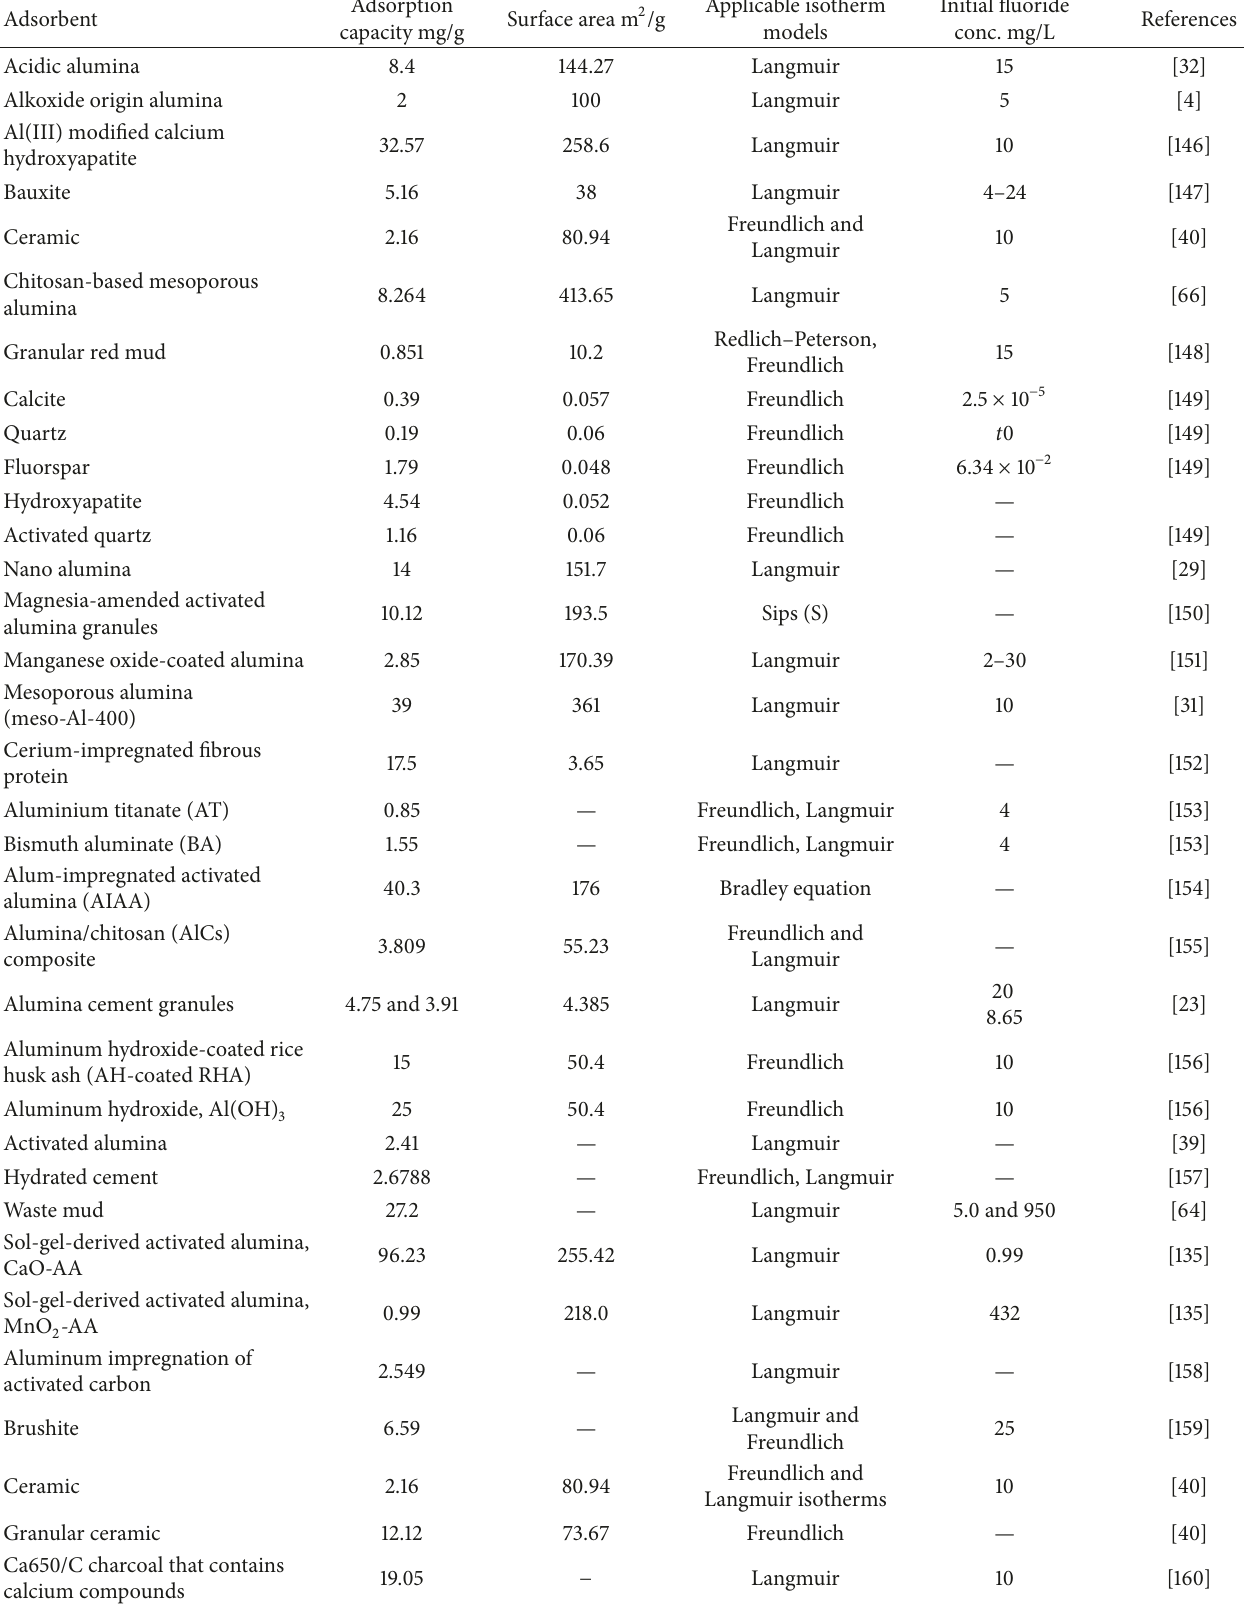
Table 2: Adsorption isotherm for fluoride (F − )